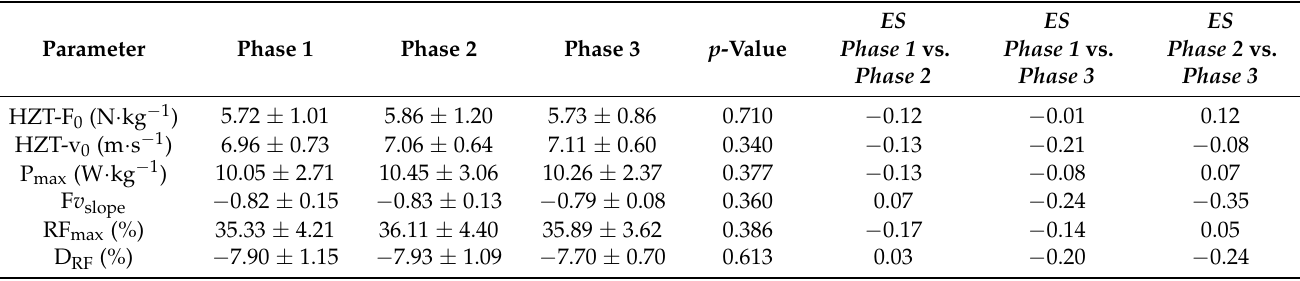
Table 3. Power–force–velocity relationship parameters during a 30 m linear sprint test obtained from three different phases of the menstrual